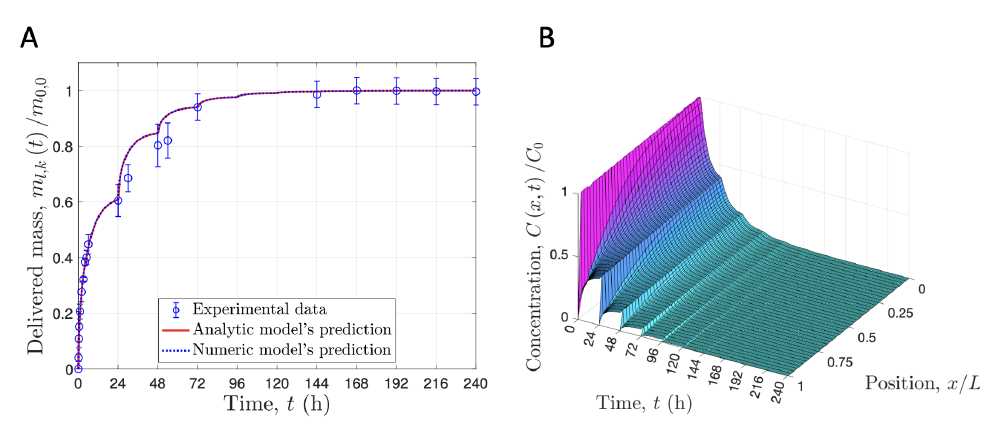
Figure 8. Recursive drug delivery. ( A ) Comparison of the experimental data and prediction for the delivered rose bengal. ( B ) Prediction of the drug concentration profile in the HP- β -CD/CTR matrix. Adapted from [14], with permission from